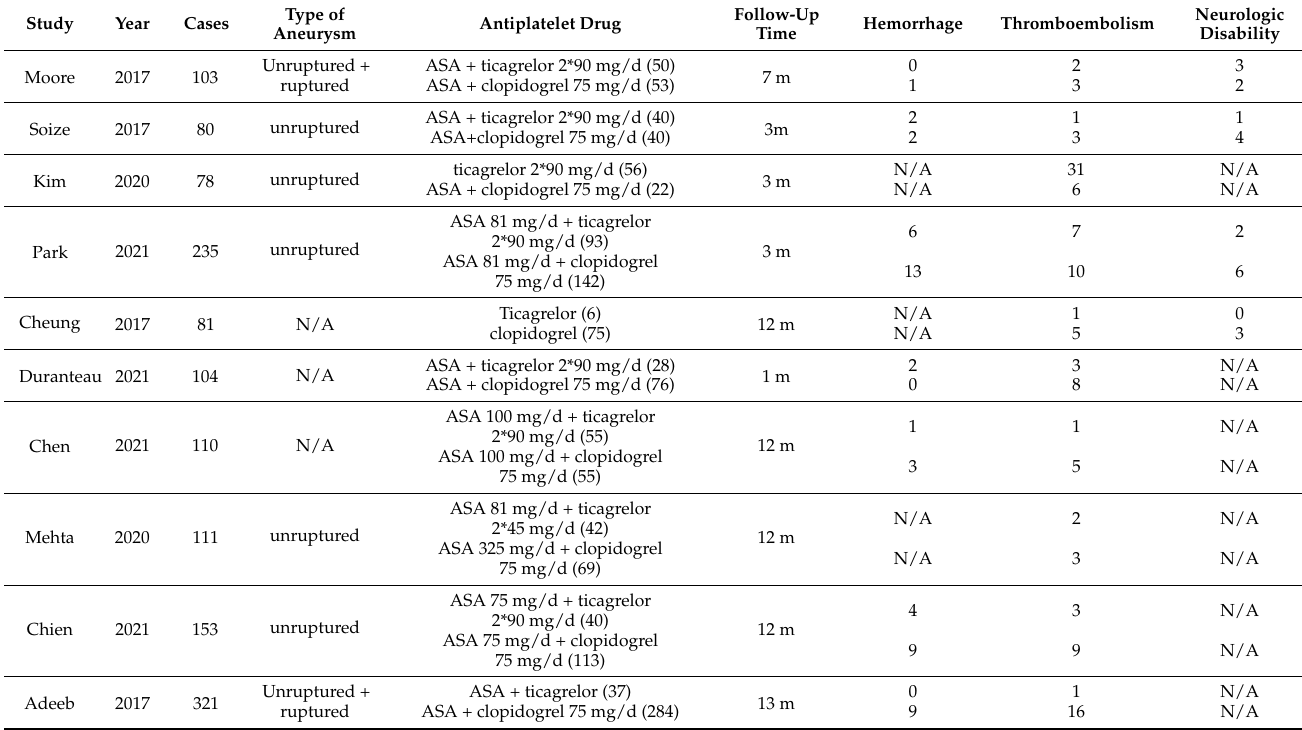
Table 1. Characteristics of studies included in the